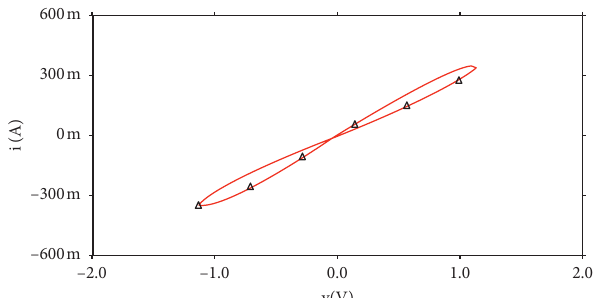
Figure 1: Pinched hysteresis loop of the memristor with α � 2 and β � 0.1 ( f �